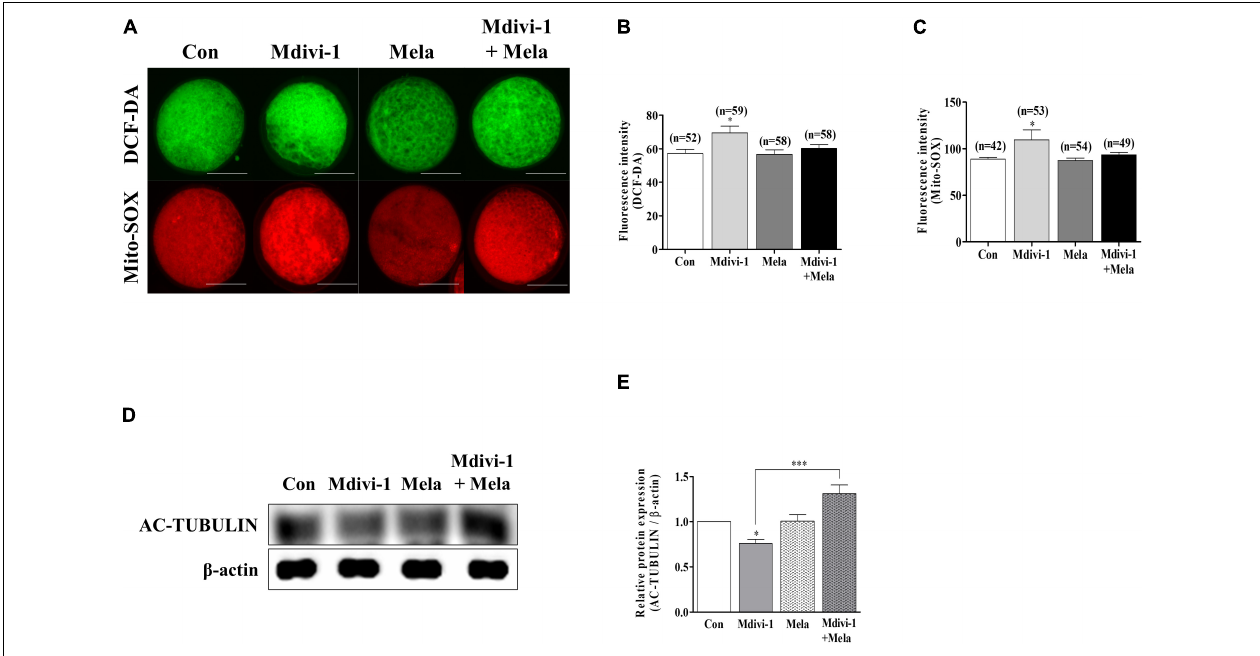
FIGURE 7 | Effects of melatonin on the intracellular and mitochondrial reactive oxygen species (ROS) and tubulin formation-related protein in mature porcine oocytes. (A–C) Fluorescence intensity of intracellular (green) and mitochondrial (red) ROS using DCF-DA and Mito-SOX staining. Scale bar: 100 µ m. (D,E) Representative Western blot of the AC-TUBULIN protein level in the control, mitochondrial division inhibitor 1 (Mdivi-1), melatonin, and Mdivi-1 + melatonin groups. Here, β -actin was used as a loading control. Data in the bar graph represent the mean ± SEM of three independent experiments ( ∗ p < 0.05; ∗∗∗ p <